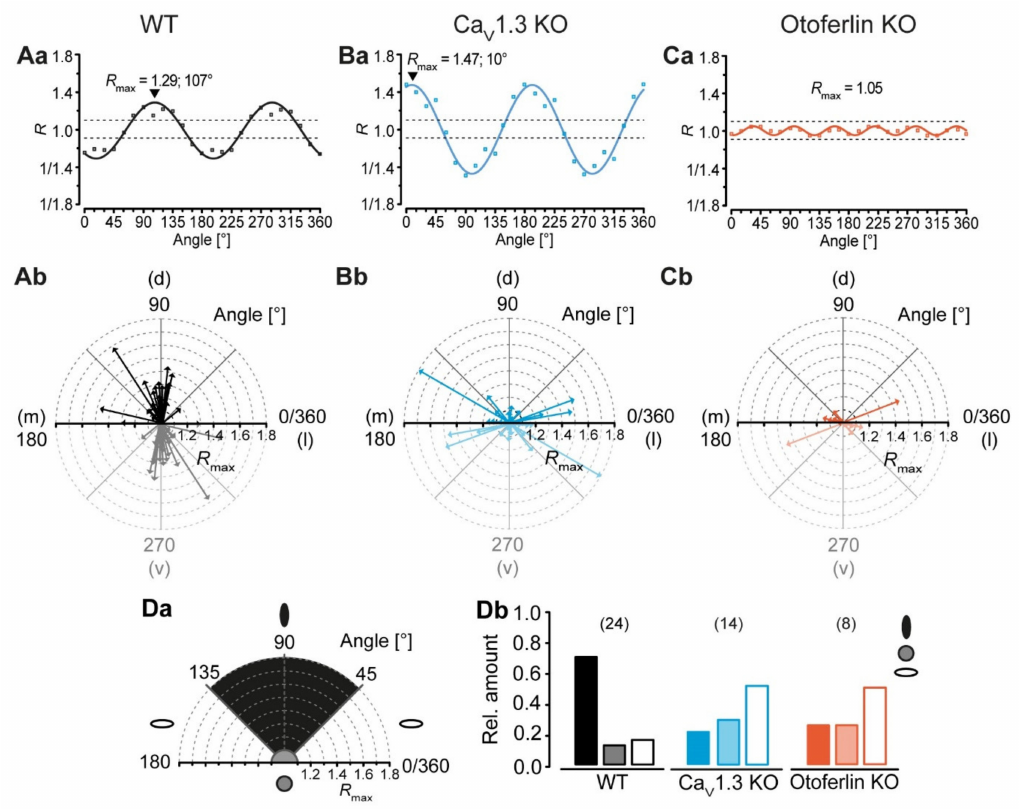
Figure 4. LSO astrocyte networks show a disturbed topography in Ca V 1.3 KO and otoferlin KO mice. ( A – C ), analysis of network topography. The coordinate system was step wise rotated and the ratio of tracer extent was calculated using the vector means approach. The anisotropy and orientation of networks in the center of the LSO were determined using a sinusoidal function ( Aa – Ca ). Shown, are representative sinusoidal fits of the anisotropic networks that were oriented orthogonally (WT; Aa) and parallel to the tonotopic axis (Ca V 1.3 KO; Ba) as well as a fit of an isotropic network with no preferential orientation (otoferlin KO; Ca). ( Aa – Ca ) refer to networks shown in Figure 3Aa–Cd. Radar diagrams displaying the anisotropy ( R max > 1.1: anisotropic; R max ≤ 1.1: isotropic) and orientation α of tracer-coupled networks ( Ab – Cb ). The mediolateral (m-l) axis resembles the tonotopic axis, the dorsoventral (d–v) axis resembles the orientation of isofrequency bands, which are oriented orthogonal to the tonotopic axis. In WT mice, most tracer-coupled networks showed a preferential orientation orthogonal to the tonotopic axis (d–v; 45 ≤ α < 135 ◦ ) ( Ab ). In contrast, the majority of anisotropic astrocyte networks in Ca V 1.3 KOs and otoferlin KOs were aligned parallel to the tonotopic axis (m-l; α < 45 ◦ and α ≥ 135 ◦ ) ( Bb – Cb ). ( D ), classification of networks. Astrocyte networks were a ffi liated to three classes by their shape R max and orientation α (class 1, black ellipse: anisotropic and oriented orthogonally to tonotopic axis; class 2, grey circle: isotropic; class 3: anisotropic and oriented parallel to the tonotopic axis; Da ). In WT mice, most LSO astrocyte networks were categorized into class 1. In contrast, tracer-coupled networks in KOs were predominantly a ffi liated to class 3 ( Db ). The WT data ( Aa – Ab ) were already part of the following study: [9]. Panel Ab was reused from that